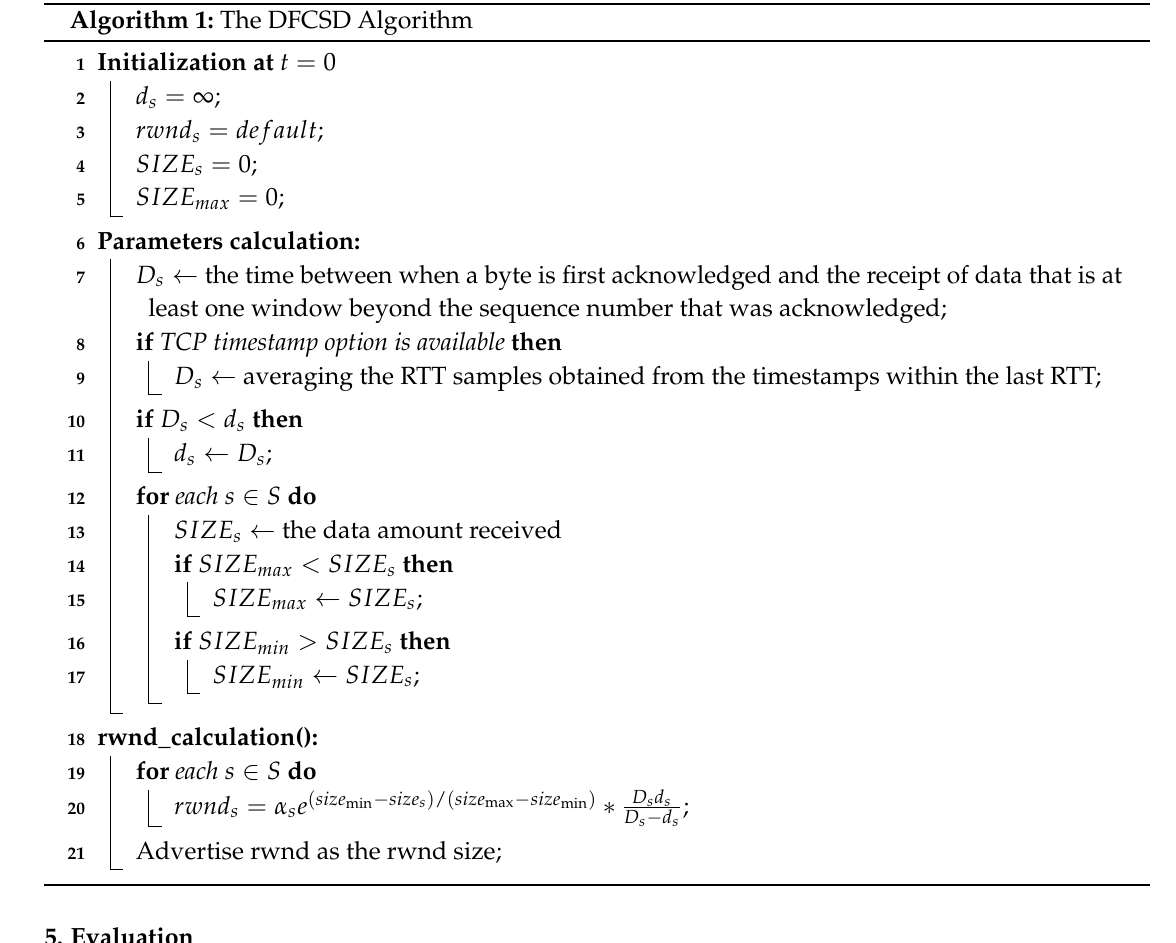
Algorithm 1: The DFCSD Algorithm